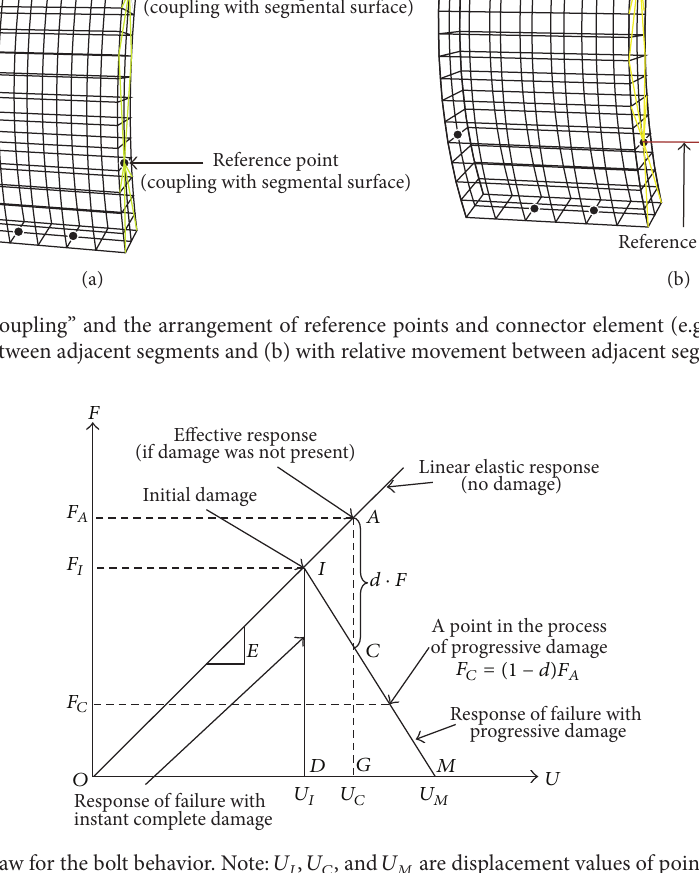
= (1−𝑑)𝐹 𝐸 is the elasticity modulus of connector element; 𝑑 is the scalar 𝐶 𝐴 ;